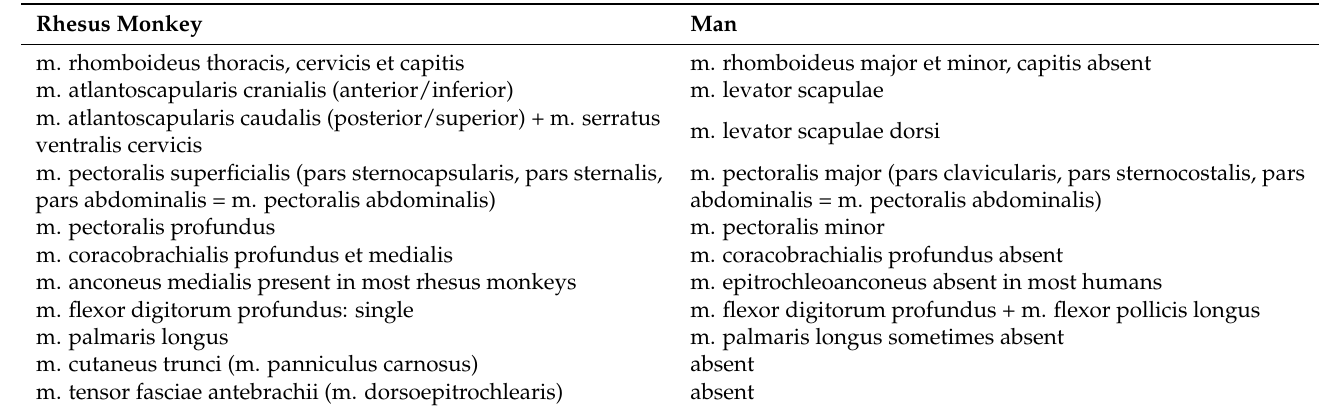
Table 1. Differences observed between the musculature of the front limb of the rhesus monkey and that of the human